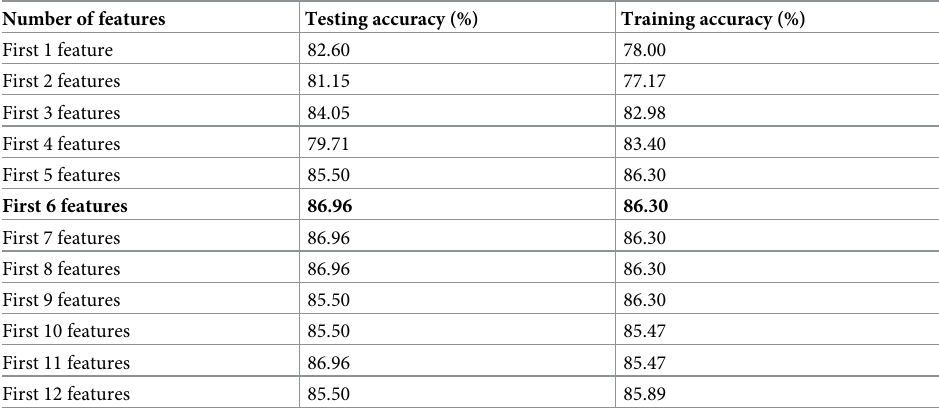
Table 3. Accuracies of SVM for different feature numbers.